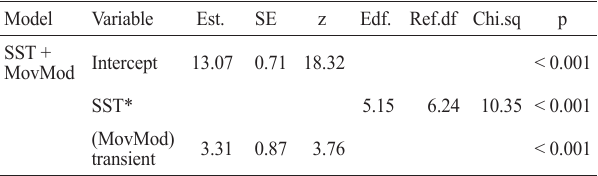
Tab. 3. Generalized additive model of the maximum diving depth. Included are the predictor variables sea surface temperature (SST) and movement mode (MovMod), the coefficient estimate (Est.), standard errors (SE), z-statistics (z) of the categorical variable, effective (Edf.) and reference (Ref.df) degrees of freedom, and χ 2 -statistics (Chi.sq) of the continuous variable, and corresponding p -values (p). (*) Variable modeled with a continuous smooth function.